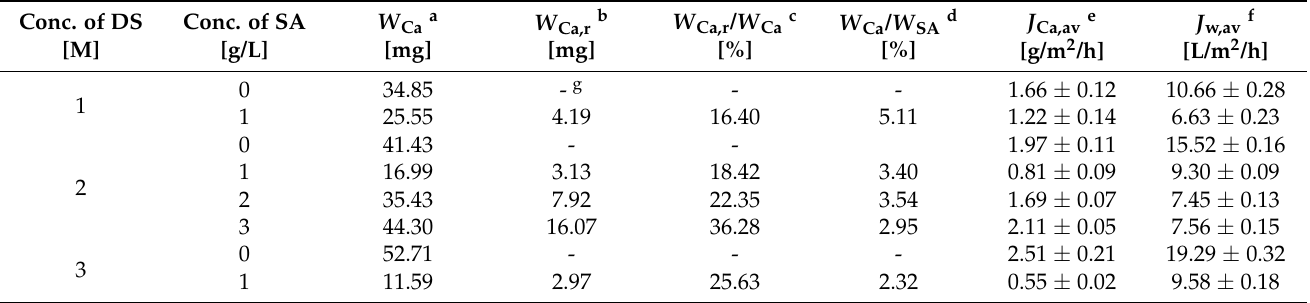
Table 1. Characteristic values in forward osmosis (FO) recovery of Ca-Alg at 5 h of FO.